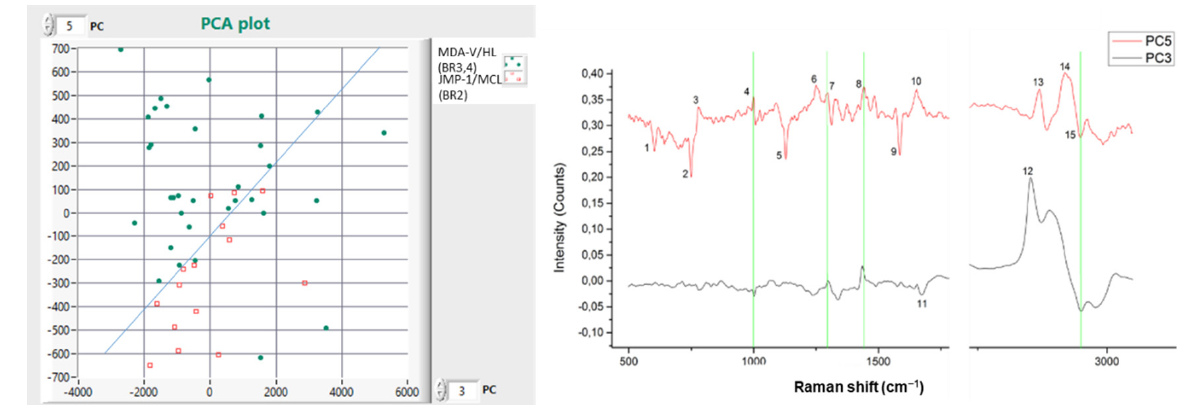
Figure 5. ( left ) Comparison between experiments BR2 (JMP-1/MCL NHL) and BR3,4 (MDA-V/HL) cell lines; ( right ) PCA Raman spectra showing the cell lines differences. Further, the Raman peaks were found and are presented in Table 4. Table 4. Major Raman peaks found in PCA between BR2 and BR3, 4. In red color and with an aster- isk superscript the temperature dependent Raman peaks are presented.